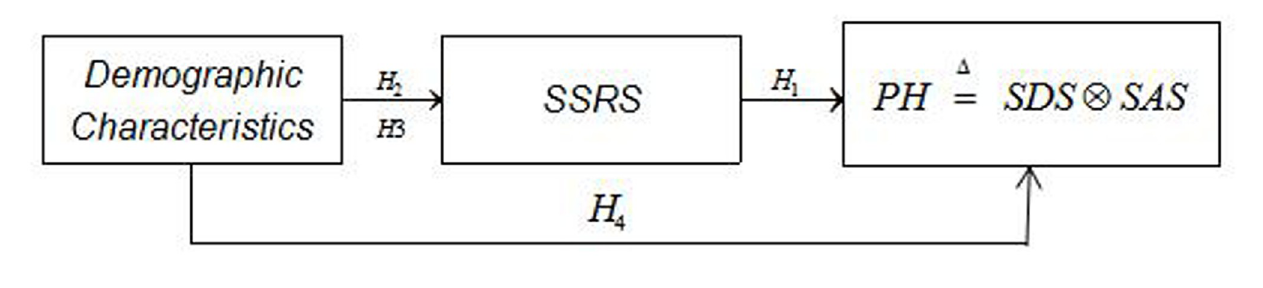
Fig 1. Conceptual model. Note: Each path is dentified by the hypothesis with which it is associated. SSRS: Social support rating scale, SDS:Self-Rating Depression Scale, SAS: Self-Rating Anxiety Scale, PH is redentified by SDS and SAS.